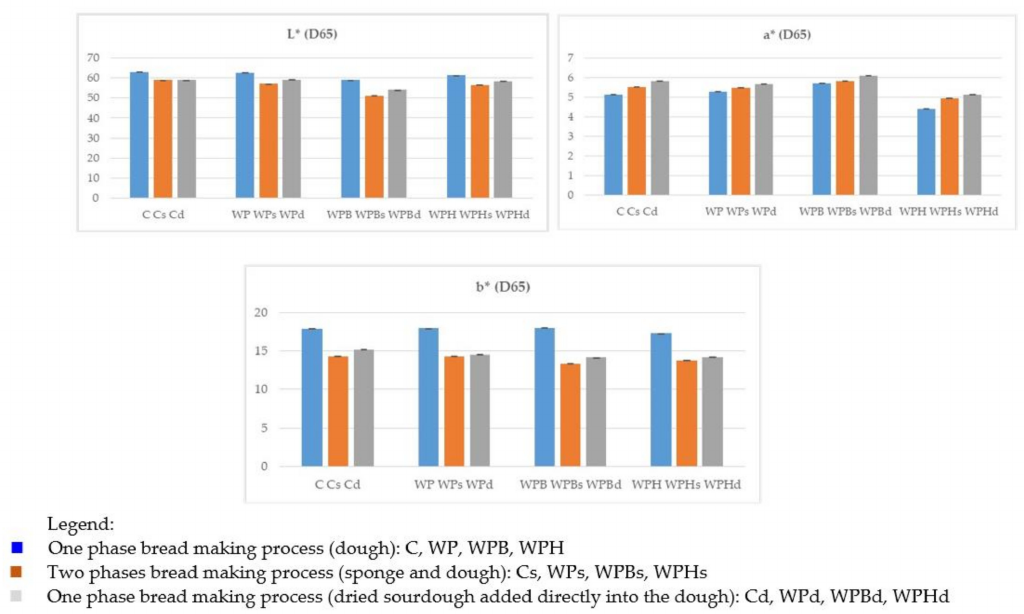
Figure 3. The results of the color analysis of the bread